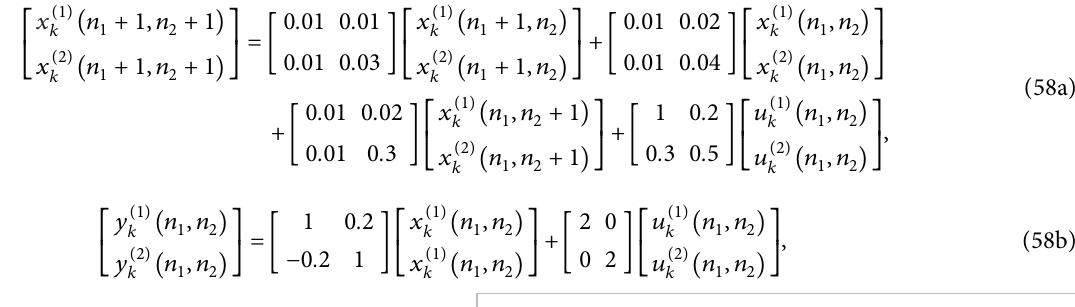
( n ,n ) at k � 3 , 5 , 7 , 20 by using the ILC law 1 2 k